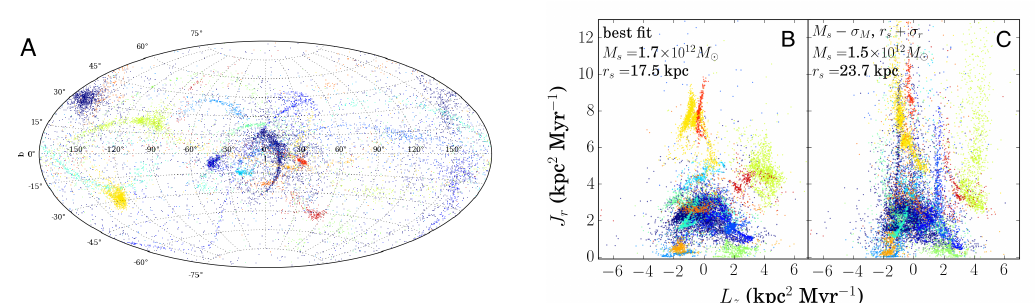
Figure 1. Panel A : tidal streams in an accreted mock stellar halo from [32] shown distributed on the sky in Galactic coordinates. Each different color represents stars from a different progenitor dwarf galaxy. Panel B : The same mock stellar halo shown in a projection of action space, calculated using the best-fit spherical NFW approximation for the gravitational potential of the dark halo. The stars in each progenitor are now clustered together around the parent orbits of the accreted galaxies they formed from. Panel C : The same mock stellar halo with actions calculated using a potential that is roughly 1 σ away from the best-fit approximation. The clustering is notably less pronounced in this incorrect action space. Figure adapted from